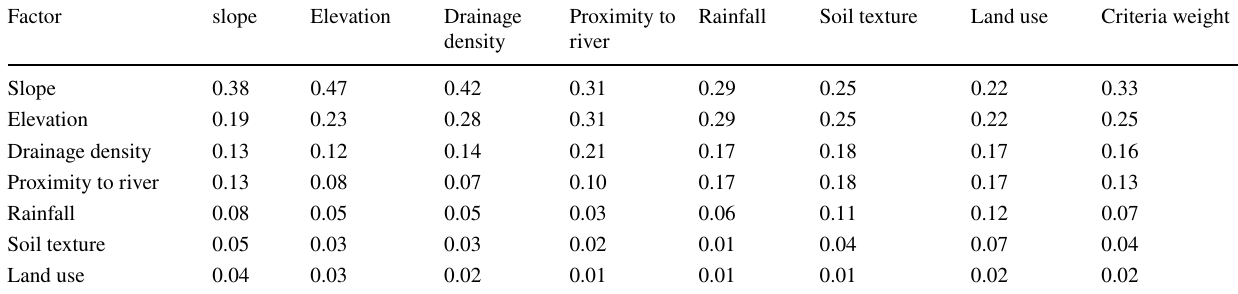
Table 5 Determined relative criterion weights